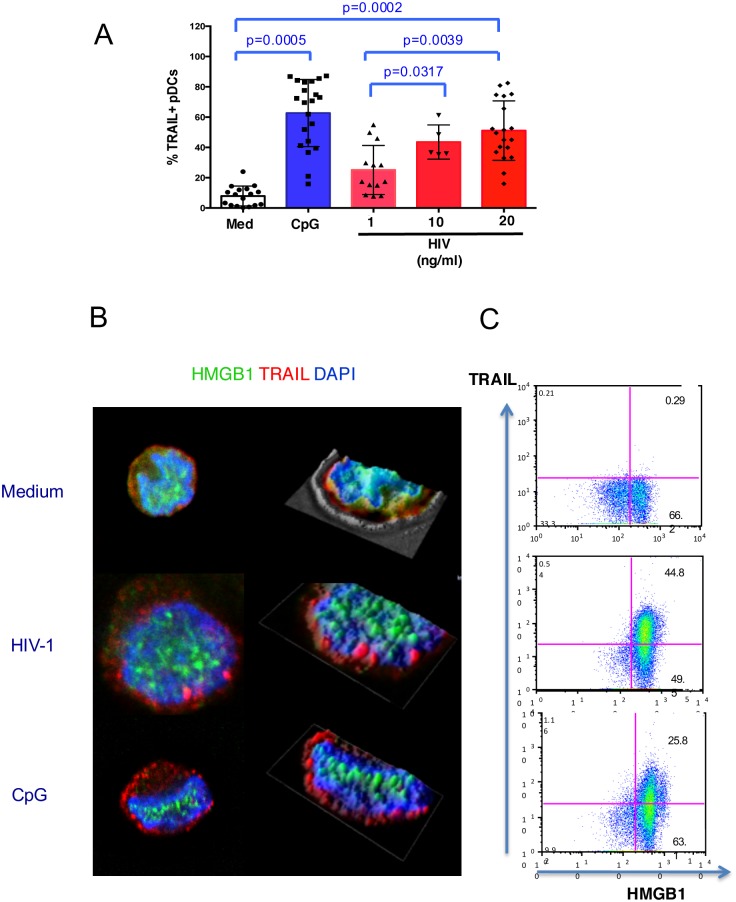
HIV-1 triggers the translocation of TRAIL from the cytoplasm to the membrane of pDCs.(A): pDCs were exposed to CpG (3 μg/ml) or increasing concentrations of HIV-1 (1 to 20 ng p24/ml) for 24 h. The expression of mTRAIL at the surface of pDCs was monitored by flow cytometry. The mean values ± SD of five independent experiments are shown (p-value ≤ 0.05 was considered significant; non-parametric Mann-Whitney test). (B): To characterize TRAIL and HMGB1 localization on pDCs exposed to HIV-1 (1ng/ml p24) or CpG (3 μg/ml), images were analysed using 3D interactive surface plot analysis. Deconvolution overlays of representative 2D red cross axis XY focal plan with XZ/YZ view of focal plane and projection overlay of cell stainings (analyzed by Metamorph software) are shown. (C): Flow cytometry analysis of mTRAIL expression and HMGB1 intracellular staining of pDCs cultured in medium, exposed to HIV-1 (1 ng p24/ml) or stimulated with CpG (3 μg/ml). Dot plots from one representative experiment out of three independent experiments are shown.